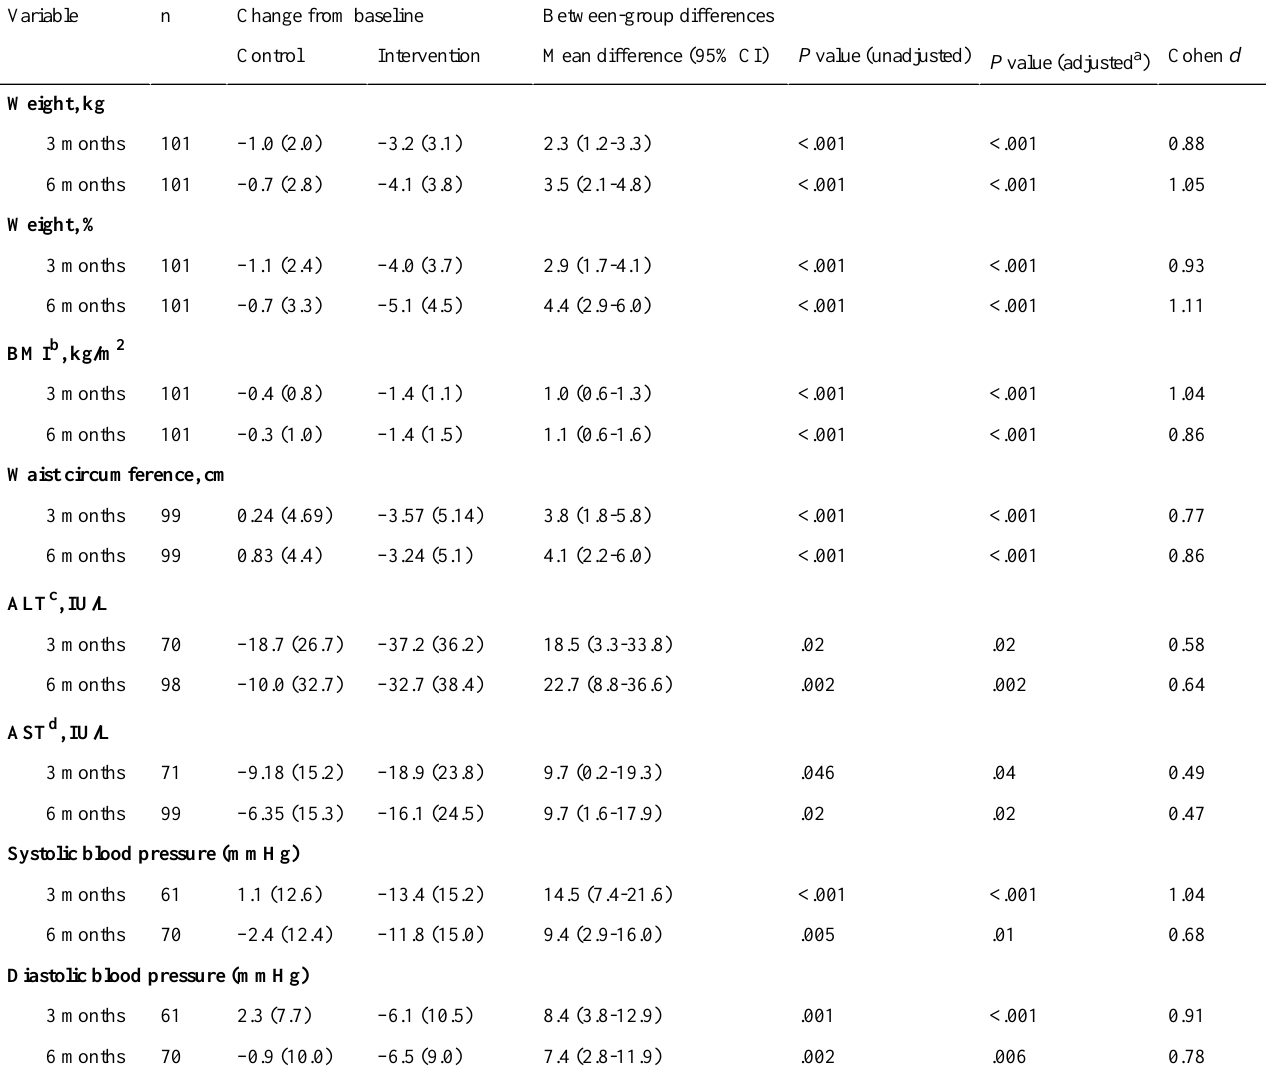
Table 4. Mean (SD) changes in anthropometric, biochemical, and clinical outcomes in patients with nonalcoholic fatty liver disease from baseline at 3 and 6 months after enrolment based on per-protocol analysis. Between-group differencesChange from